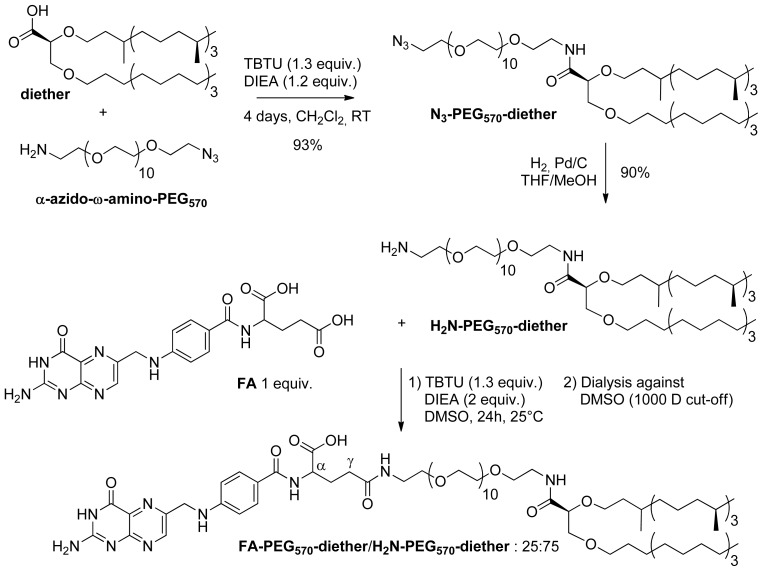
Synthesis of the H2N-PEG570-diether and FA-PEG570-diether.